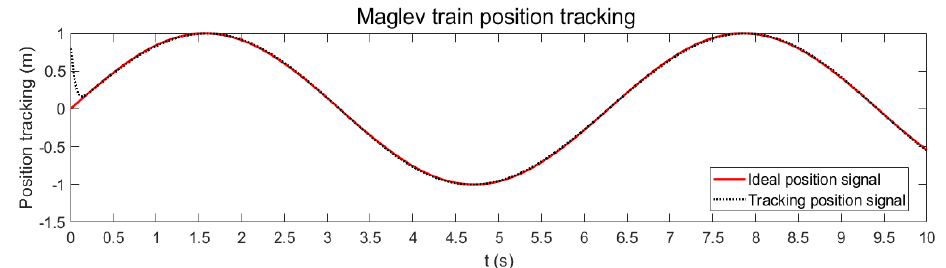
Figure 9. Output error curve.